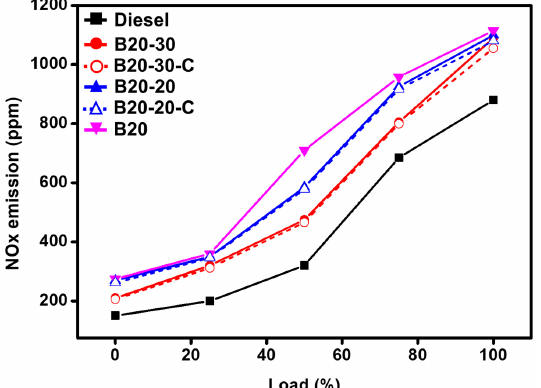
Figure 10. Comparative graphical illustration of emission of NO x vs load (%) (with ZnO-GS and ZnO-C). B20 is D-COME, i.e., discarded cooking oil methyl ester, which is blended with 20% commercial diesel; B20-20 is the blend of B20 with 20 mg of ZnO-GS/C; B20-30 is the blend of B20 with 30 mg of ZnO-GS/C.